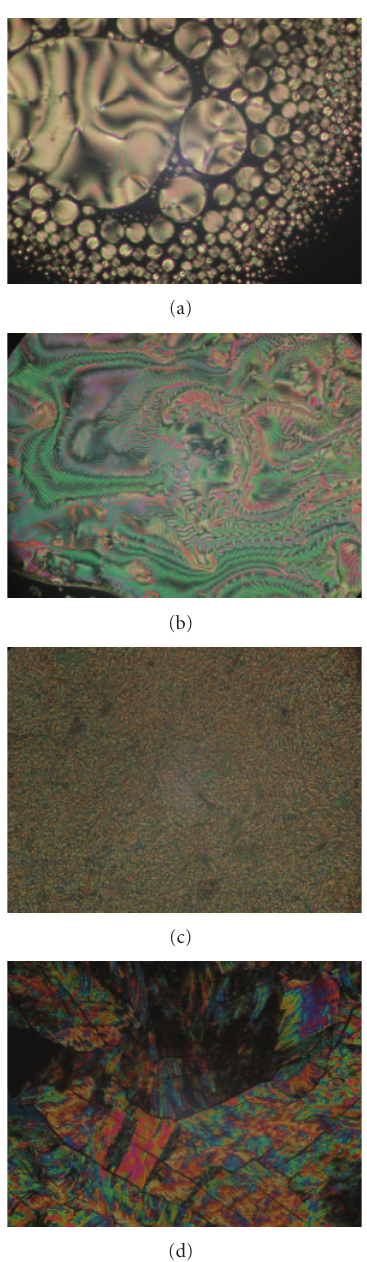
Figure 5: Polarized optical micrographs of 4-(decyloxy)benzoic acid taken during cooling from the isotropic phase at (a) 129.5 ◦ C, (b) 108.8 ◦ C, and (c) 82.9 ◦ C, (d) 25 ◦